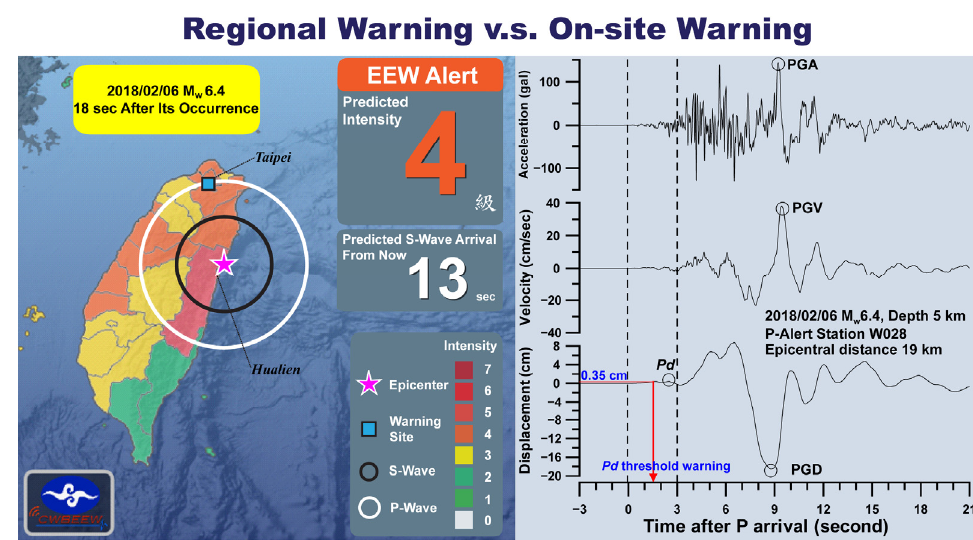
Figure 1. A comparison of time taken for the regional and on-site warnings. The left side shows that the CWB network took 18 s to issue a 13 s regional warning (lead-time) for Taipei City during the Hualien earthquake of 6 February 2018. The right side of the figure shows the P d estimation using the initial 3 s of the waveform at one of the stations of the P-Alert network, where the threshold value was achieved in 1.5 s.